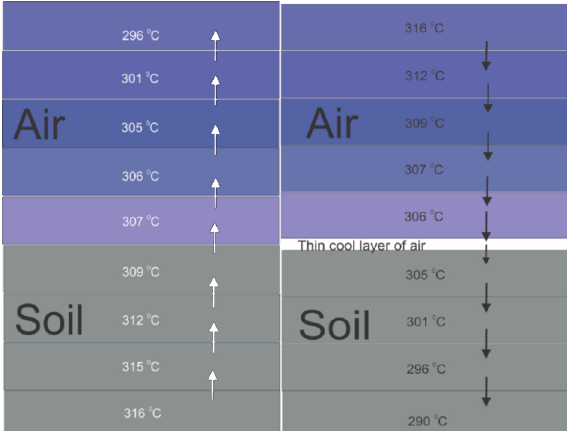
Fig. 6. Model of inert atmosphere above a planetary surface under conditions of slow warming of the solid material from the previously heated atmospheric gases above. Note the thin, stable layer of cooled air shown in white in the right-hand